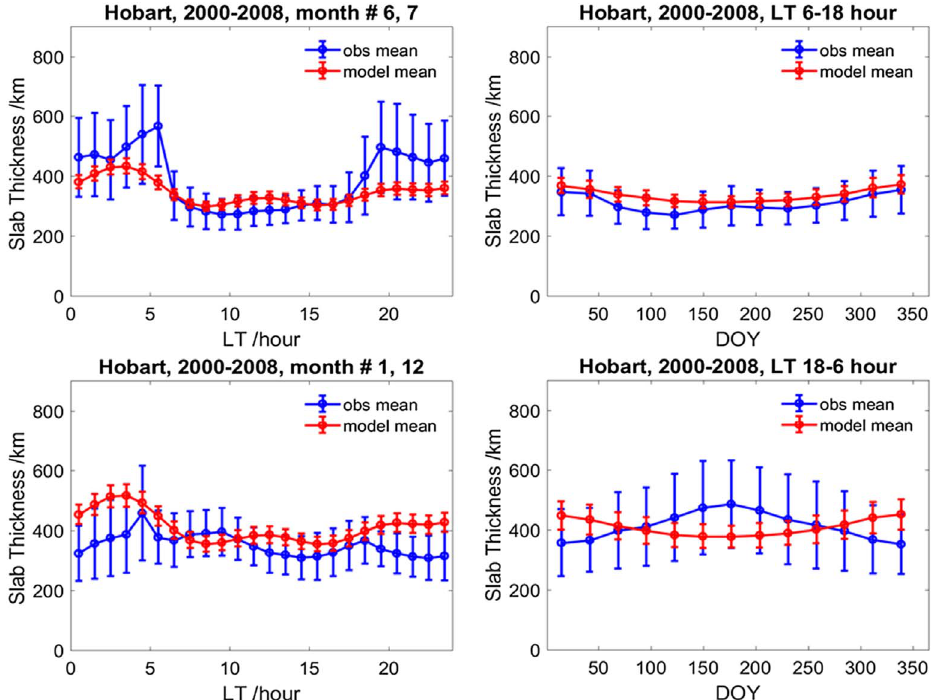
Fig. 13. Diurnal and seasonal variation of the observed and modelled s over Hobart for summer (June/July) and winter (December/January) conditions and for day (6 – 18 LT) and nighttime (18 – 6 LT) conditions,